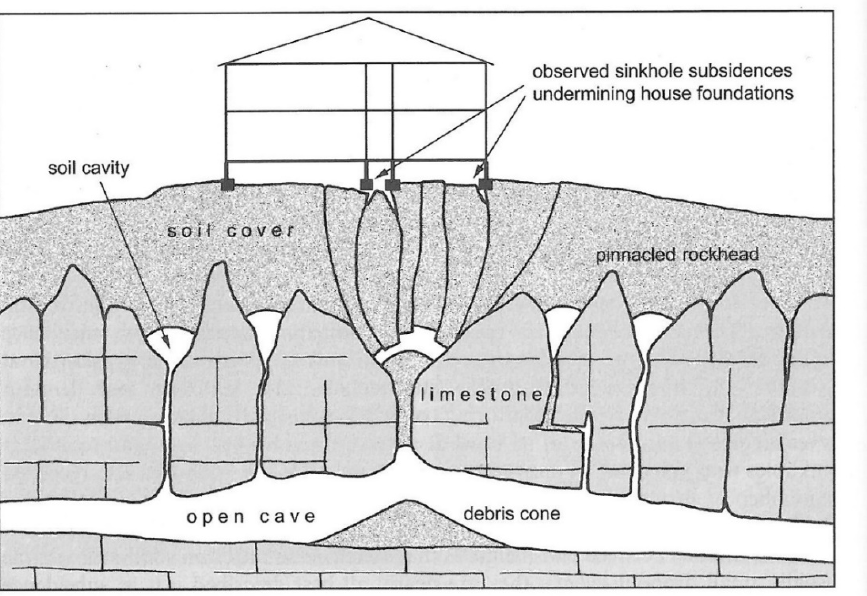
Figure 3. A model of subsidence dolines that developed above a cave and karren bedrock by cover collapses (Kentucky) [48].